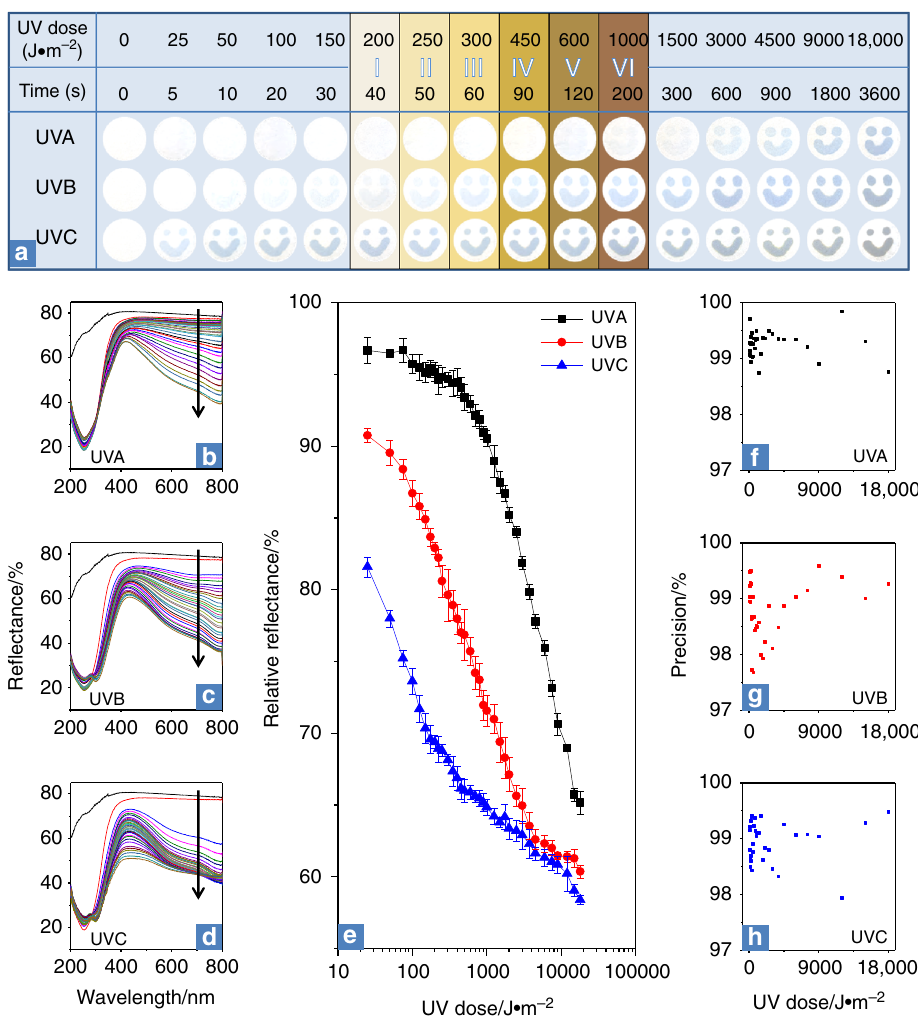
Fig. 4 The use of PMA – LA invisible ink to fabricate paper-based smiley sensors. a Photographs of three paper-based UV sensors with increasing exposure time and the corresponding cumulative effective doses of UVA, B, and C. Only selected time points of photographs are shown for clarity. The sensor response at the UVB MED doses of skin types I – VI is highlighted. The 0 s time point represents invisible smileys drawn on fi lter papers using PMA – LA ink, followed by drying. b – d Re fl ectance spectra of smileys shown in a on exposure to UVA, B, and C, respectively, with increasing UVR doses as indicated by arrows. In comparison to 16 dose points in a , re fl ectance spectra in b – d correspond to all the 35 tested doses. e UVR dose-dependent colorimetric response of PMA – LA smiley sensors demonstrating the sensor ’ s ability to differentiate UVA, B, and C even at extremely low dosages, as re fl ected from the logarithmic X -axis. Each data point represents an average of the colorimetric response obtained from four independent sensors and associated standard deviation. f – h The precision of PMA – LA smiley sensors at each of the tested UV doses, as calculated from the data presented in